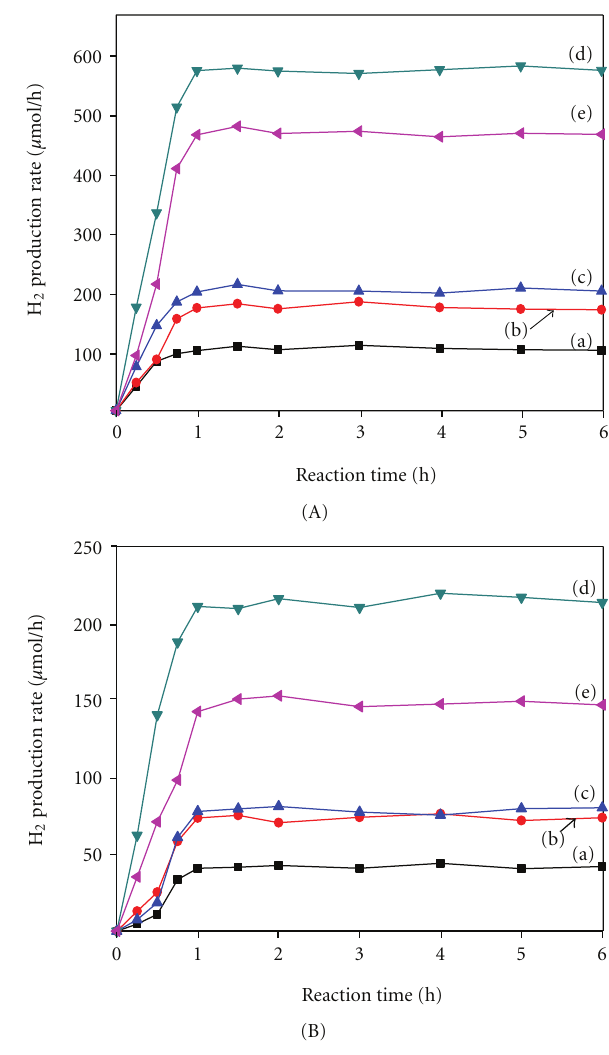
Figure 7: Rates of the photocatalytic H 2 evolution from glycerol solution (5%) over Cd 0 . 8 Zn 0 . 2 S/SiO 2 calcined at di ff erent tempera- tures under UV light (A) and visible light (B): (a) 393 K, (b) 623